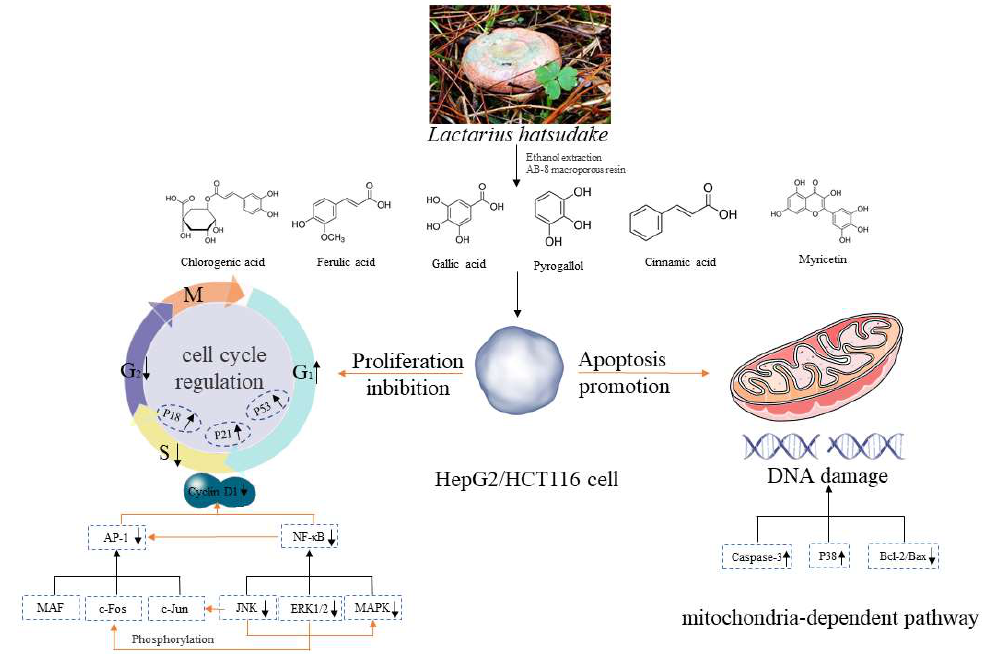
Figure 1. Composition and anticancer mechanism of L. hatsudake extracts.